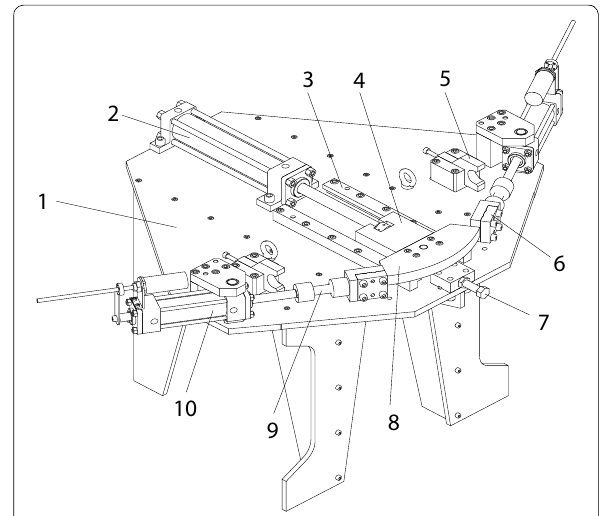
Figure 11 Concrete structure of the actuator. 1. Workbench, 2. Bending cylinder, 3. Guide rail, 4. Bending slider, 5. Jig locator, 6. Jig, 7. Bending stopper, 8. Bending mould, 9. Tension sensor, 10. Stretch